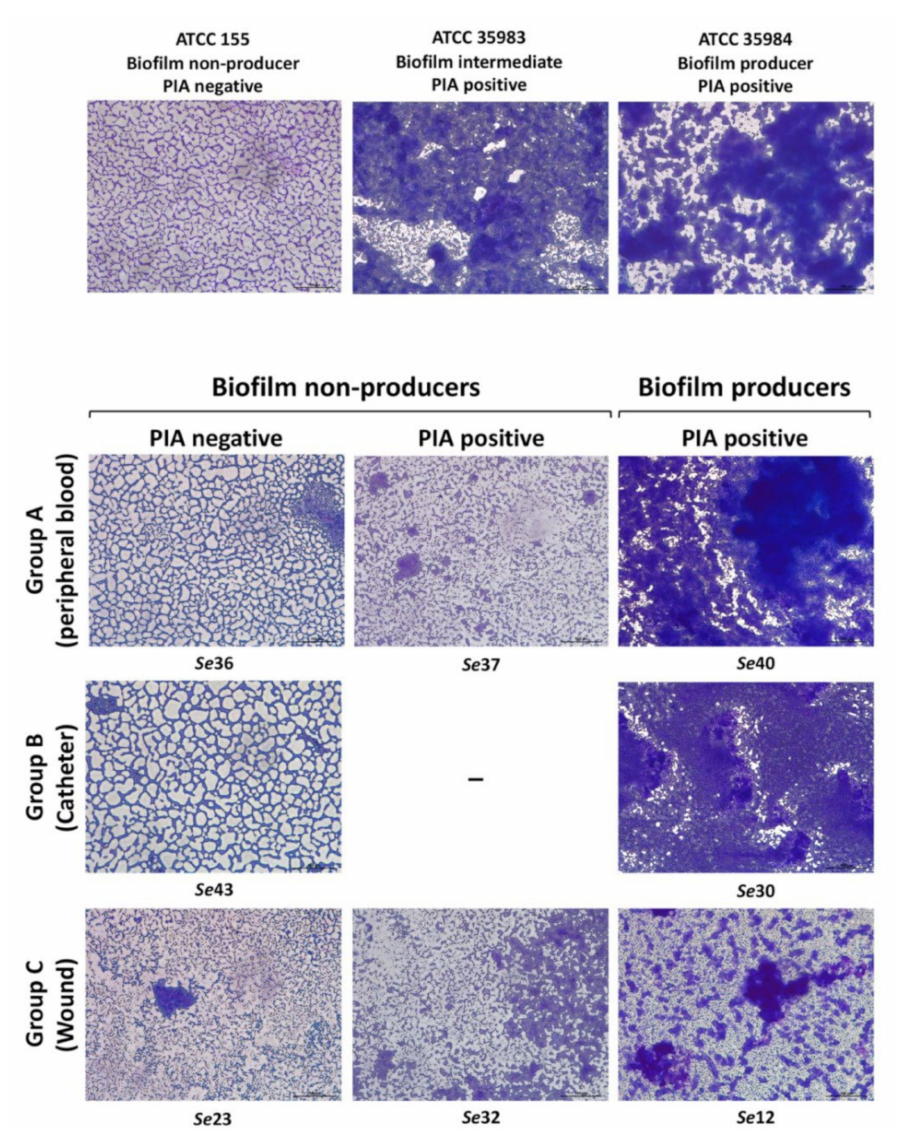
Figure 5. The visualization of the biofilm structure and matrix production among the S. epidermidis clinical isolates. Giemsa staining of the biofilms of the S. epidermidis reference strains (upper panel) and clinical isolates (lower panel) showing the different biofilm architectures formed by bacteria cultured on glass coverslips. The name of each clinical strain, subdivided according to their biofilm and PIA production, has been reported. Images were taken with a 200 × magnification, the scale bars (bottom right corner of each image) represent 100 µ